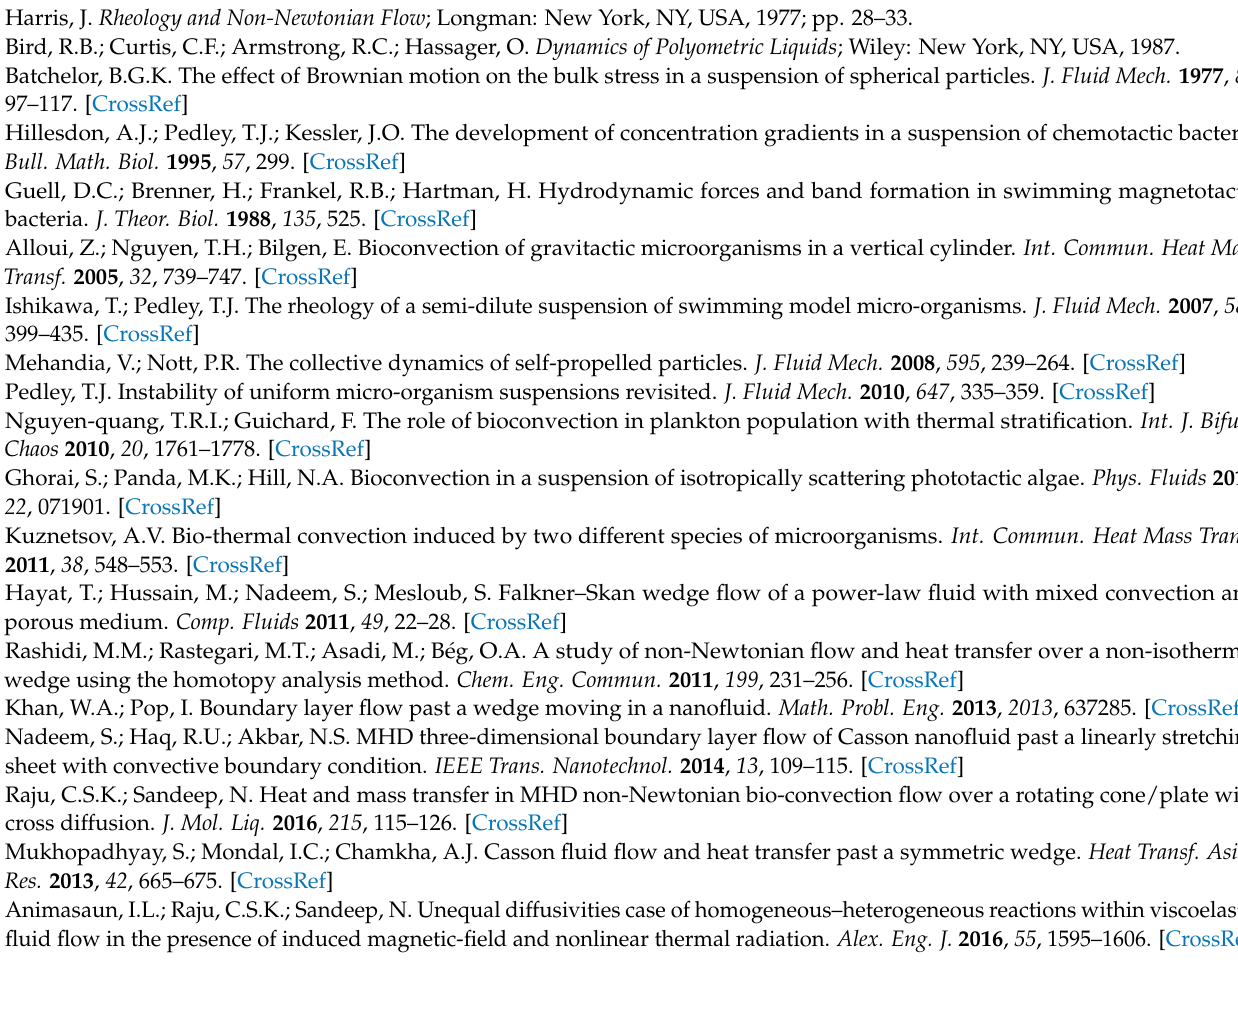
Figure 2. ( a ) DE based exploration in ℝ (cid:2870) ( b ) Schematic diagram of NMS method.